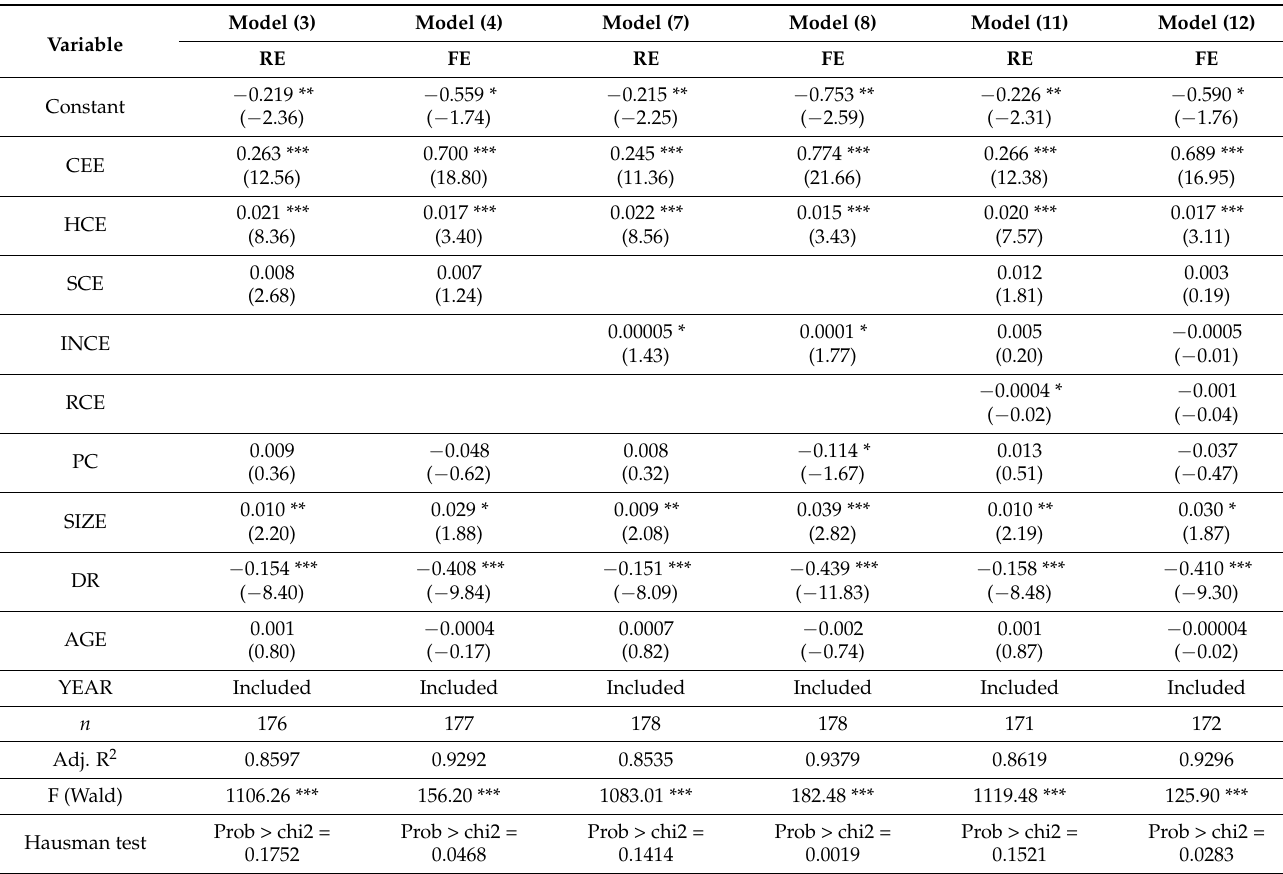
Table 11. Robustness check results of Models (3), (4), (7), (8), (11), and